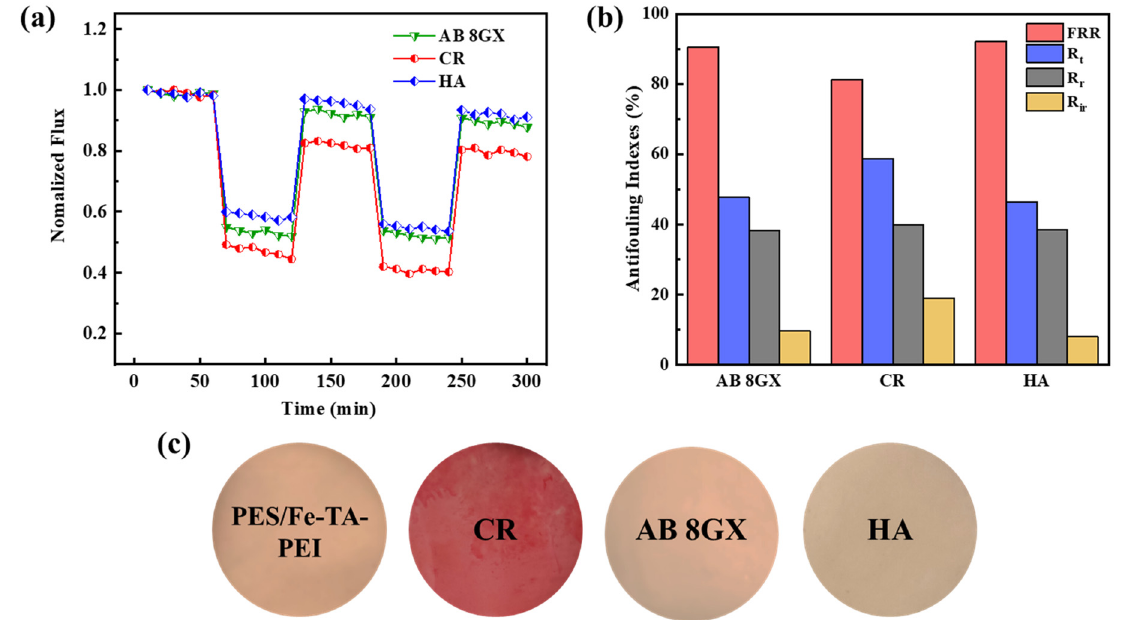
Figure 8. Membrane fouling during filtration of CR, AB 8GX, and HA solution with PES/Fe-TA-PEI membranes: ( a ) nor- malized flux, ( b ) antifouling indexes, and ( c ) membrane comparative photographic images before and after fouling.